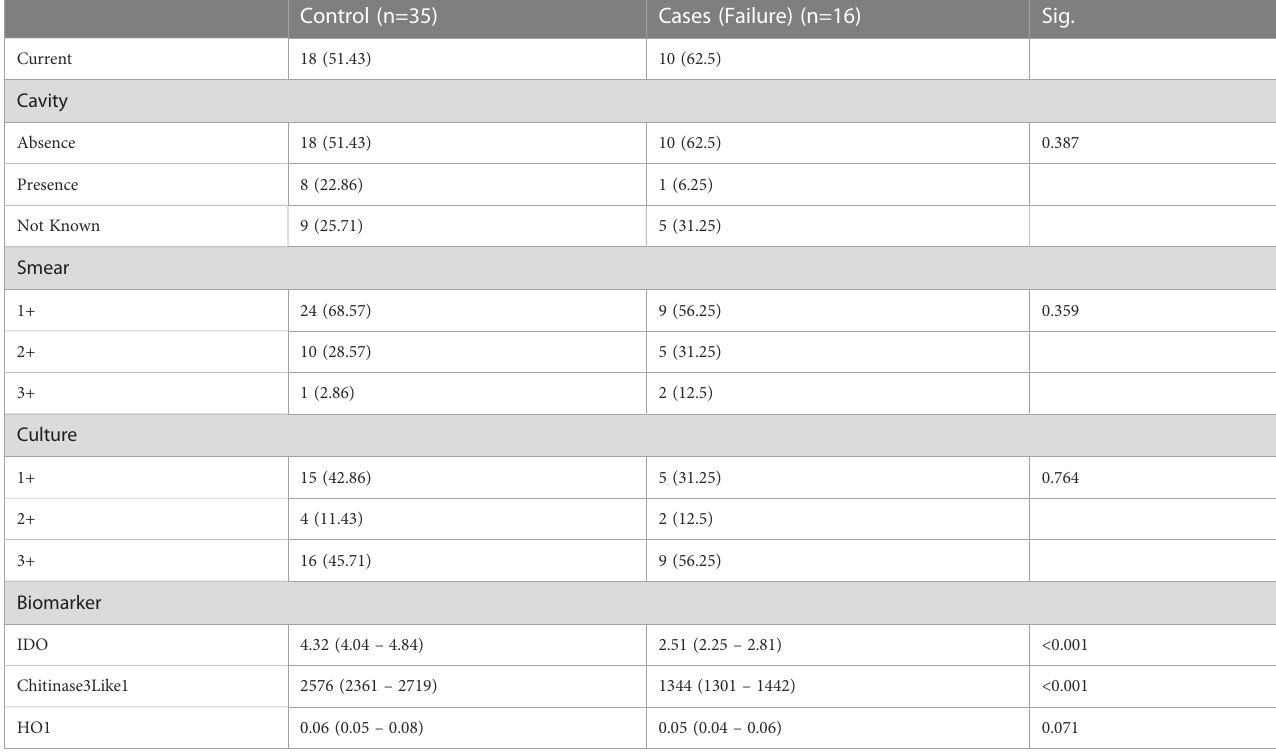
patients at baseline. As shown in Figure 2D, the plasma levels of chitinase protein (GM of 1391 pg/mL in treatment failure versus 1731 pg/mL in controls) and IDO protein (Figure 2E) (GM of 2.4 ng/mL in treatment failure versus 3.4 ng/mL in controls) were signi fi cantly lower in treatment failure individuals compared to controls, while the plasma levels of HO-1 (Figure 2F) showed no statistically signi fi cant differences between the groups. To perform a secondary analysis of differences in TB recurrence vs controls, we measured the expression of these markers in the patients at baseline. As shown in Figure 2G, plasma levels of chitinase protein (GM of 1397 pg/ml in recurrence versus 2066 pg/mL in controls) and IDO protein (Figure 2H) (GM of 3 ng/mL in recurrence versus 3.9 ng/mL in controls) were signi fi cantly lower in recurrence compared to controls, while the plasma levels of HO- 1 (Figure 2I) showed no statistically signi fi cant differences between the groups.